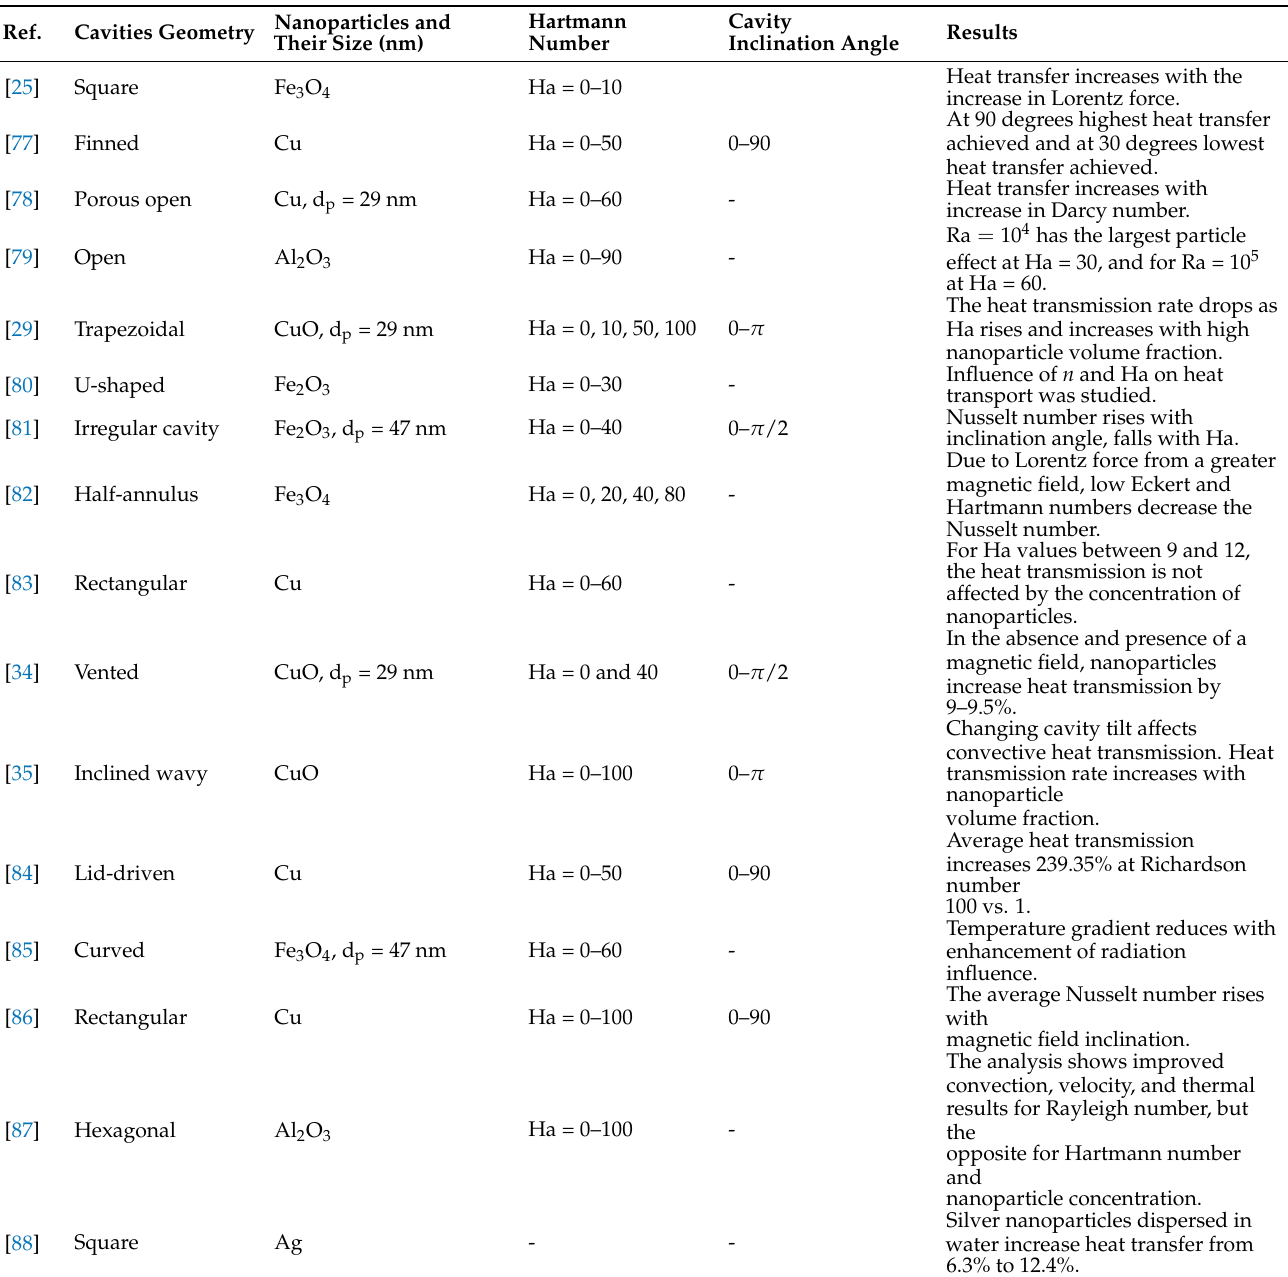
Table 3. Different parameters studied in MHD